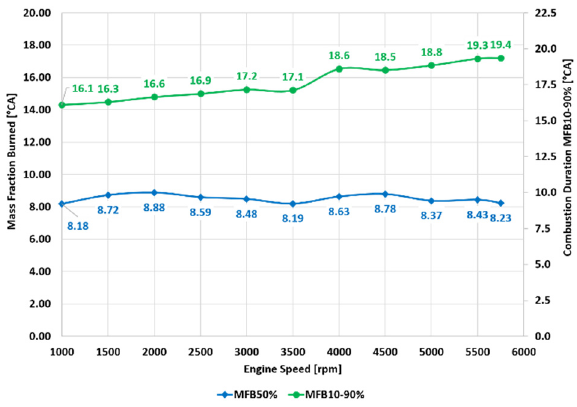
Figure 16. The MFB50% and the combustion duration MFB10–90% achieved at full load engine simulation.